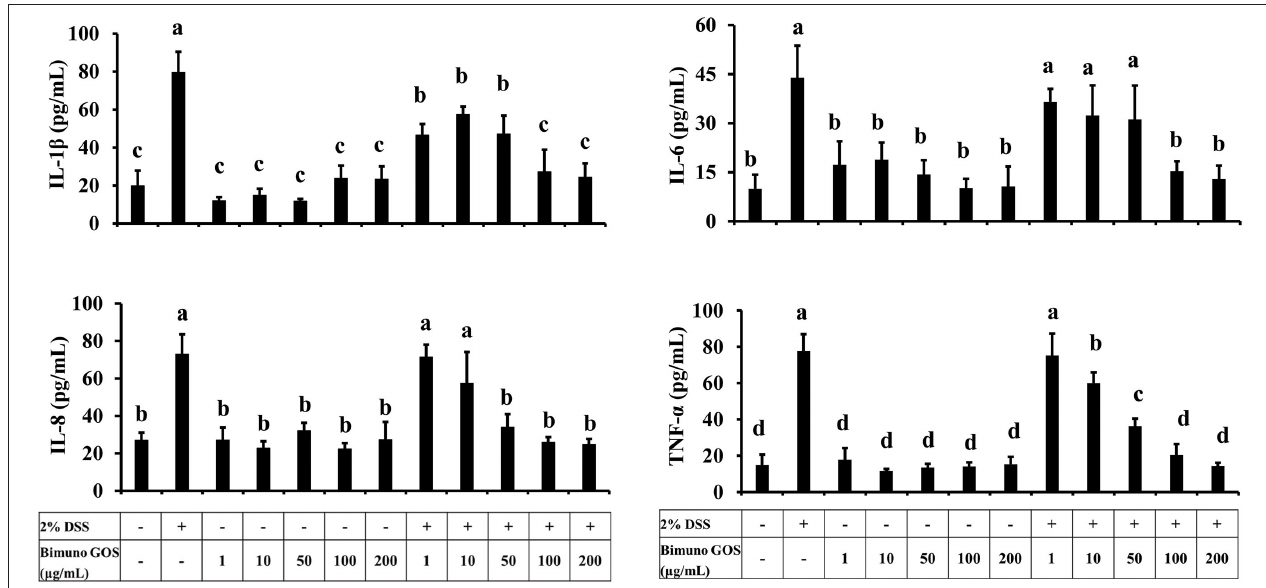
FIGURE 5 | Pro-inflammatory cytokine secretion in presence of different concentrations of Bimuno GOS and/or DSS in Caco-2 cells. Cells were untreated, or treated with 2% DSS alone for 6h, or treated with 100 or 200 µ g/ml Bimuno GOS alone for 4h, or treated with 2% DSS for 2h and then with 100 or 200 µ g/ml Bimuno GOS for further 4h. Values represent means ± SD of three independent experiments, carried out in triplicate. Means without a common letter significantly differ, P <